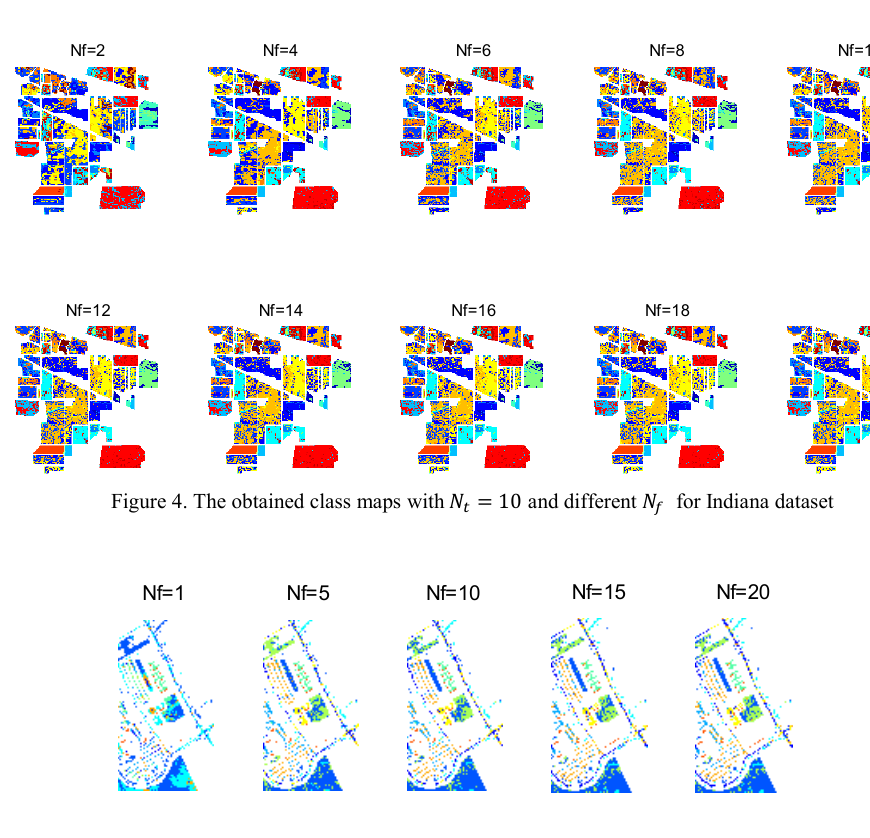
and different (cid:13) for Pavia university 3 = 10 4